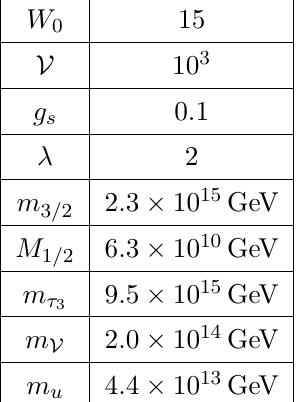
is obtained from (3.8) 1 / 2